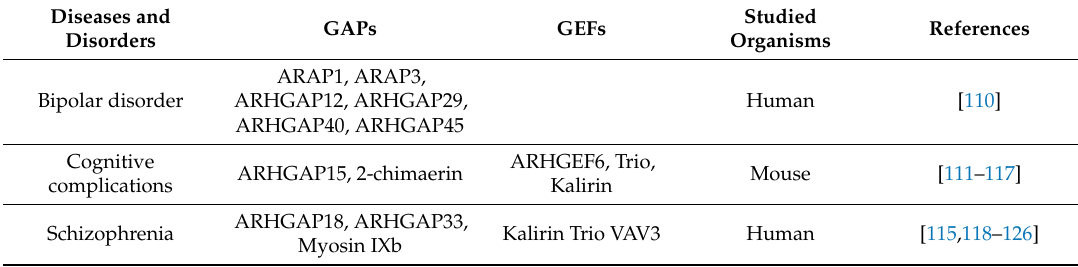
Table 2. GAPs and GEFs in neurological diseases and